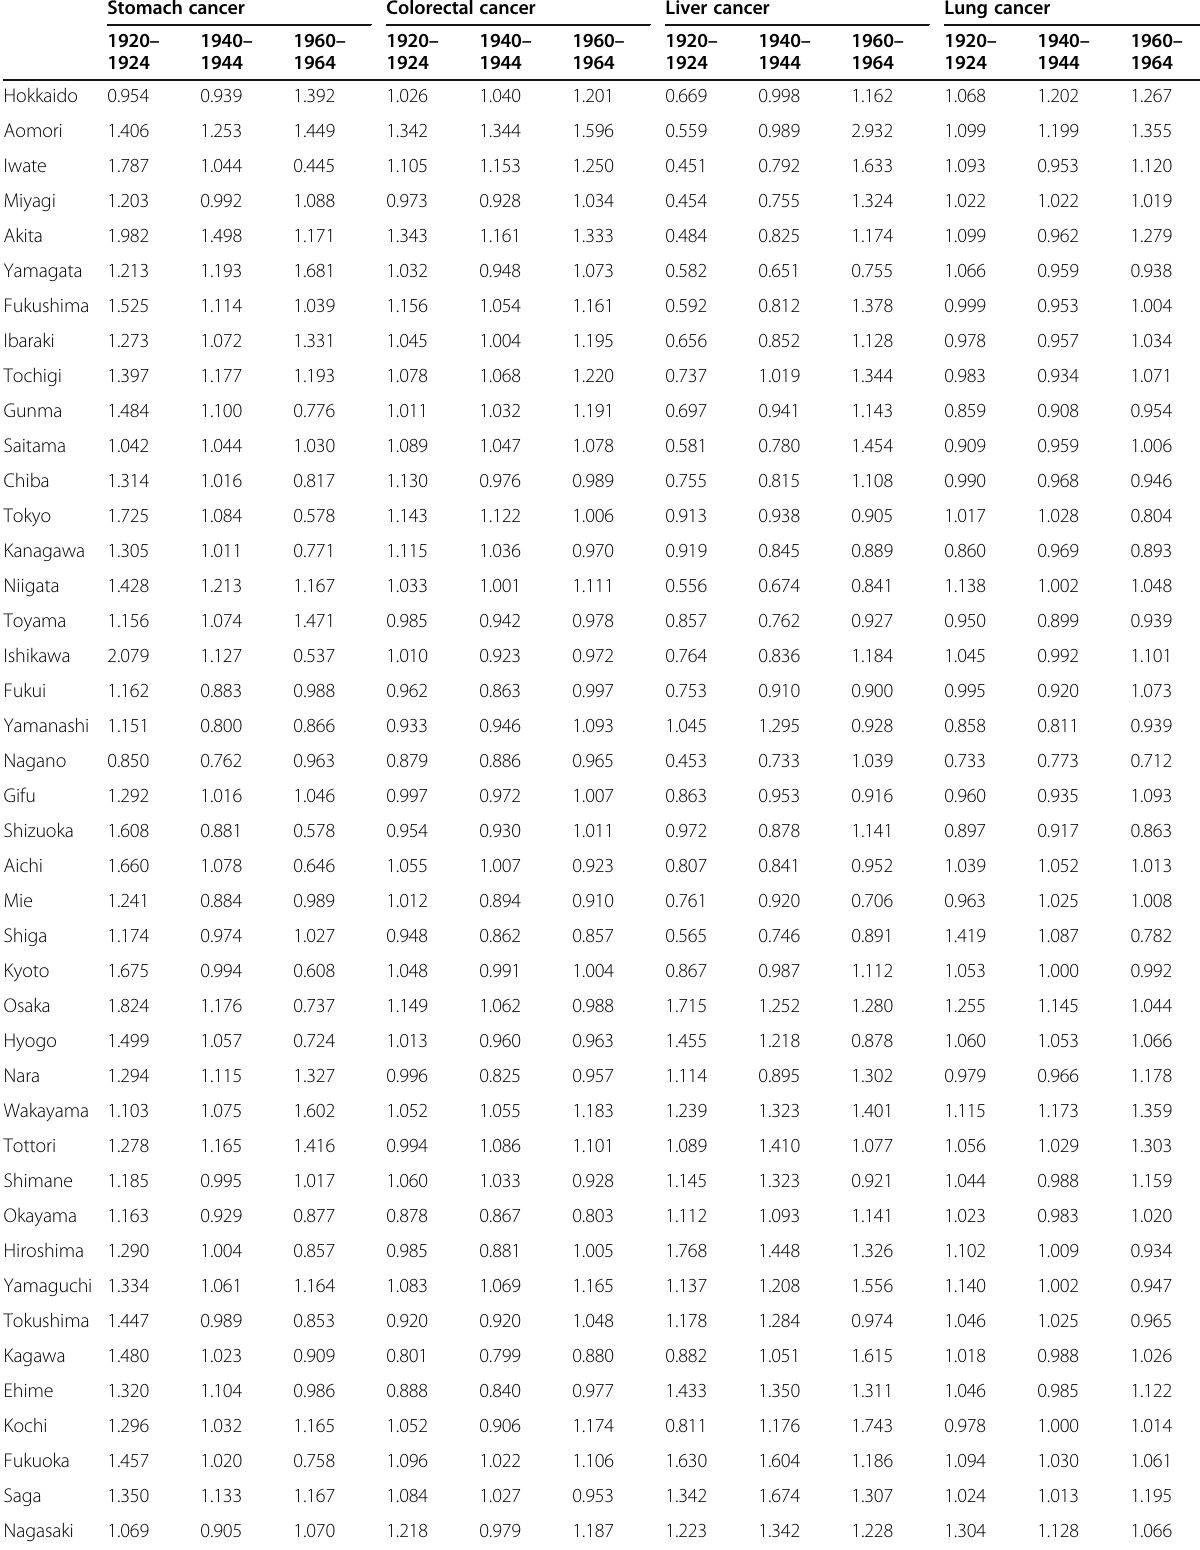
Table 4 Mortality rate ratio of a prefecture to all of Japan on each cohort in men Stomach